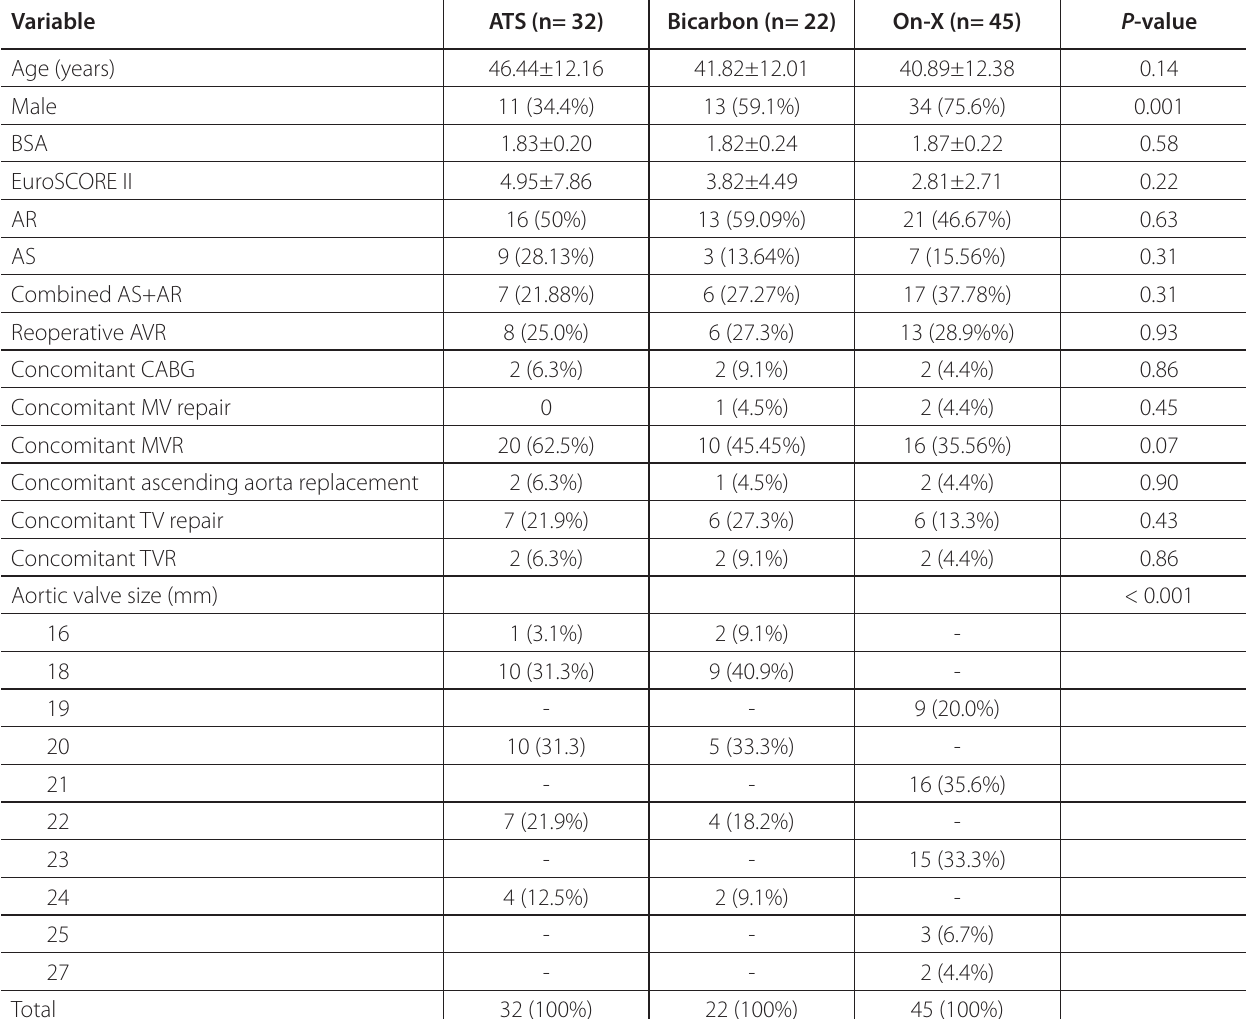
Table 1 . Baseline characteristics and operative